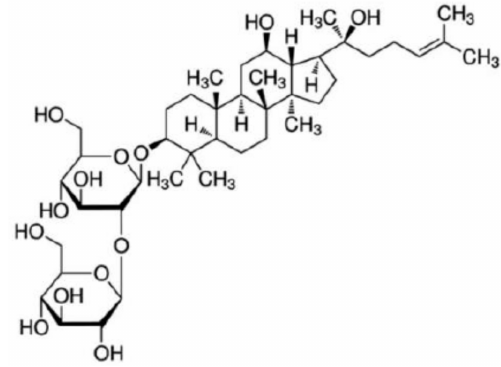
Figure 6. Chemical structure of ginsenoside